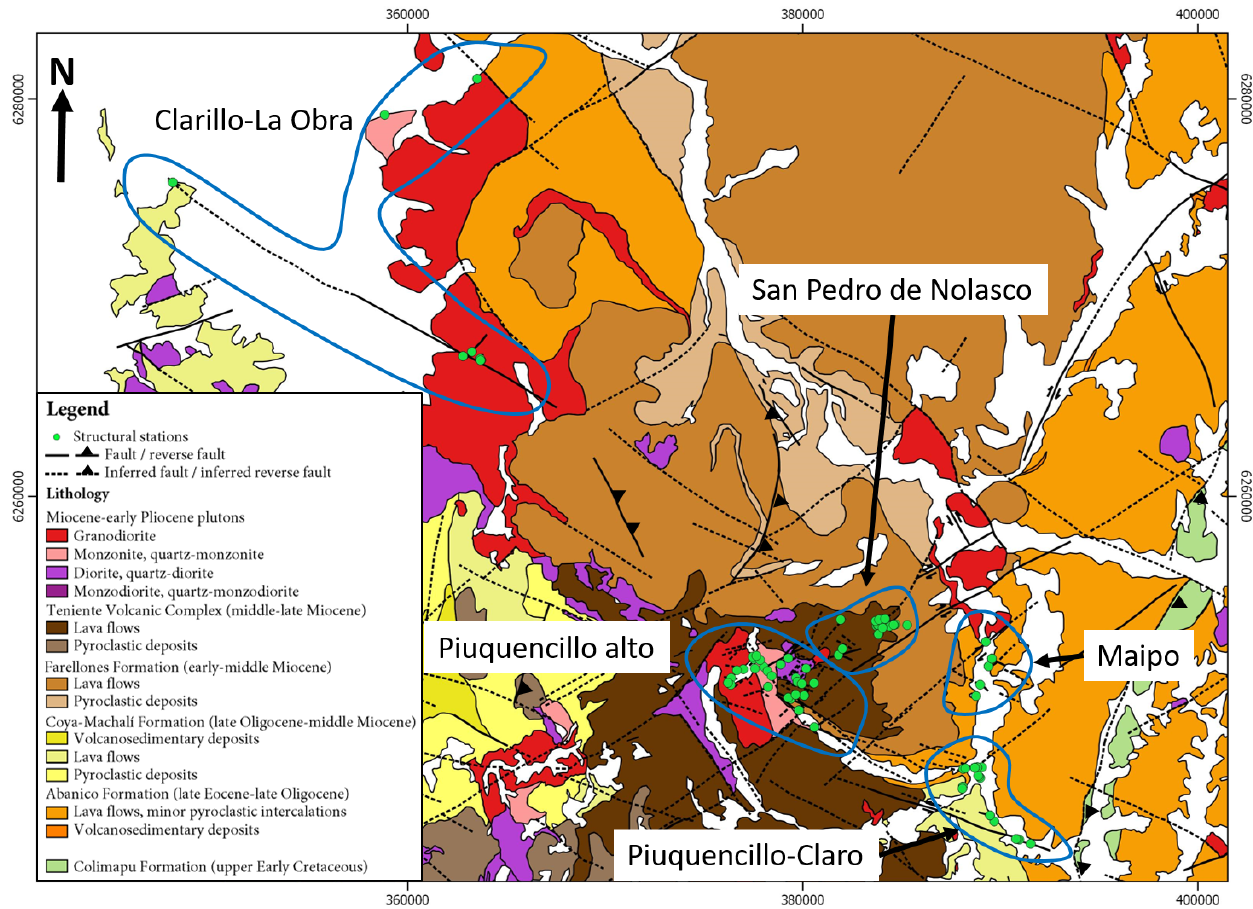
Figure 5. Subdivision of the study area into five sectors for the analysis of preferred orientations and the calculation of strain axes and stress tensors. The geological map in the background was compiled from Rivera and Cembrano (2000), SERNAGEOMIN (2002), Fock (2005), Fock et al. (2005), Piquer (2015) and this work. Table 1. Summary of U–Pb zircon geochronology of the La Obra batholith. UTM is Universal Transverse Mercator. MSWD is mean squared weighted